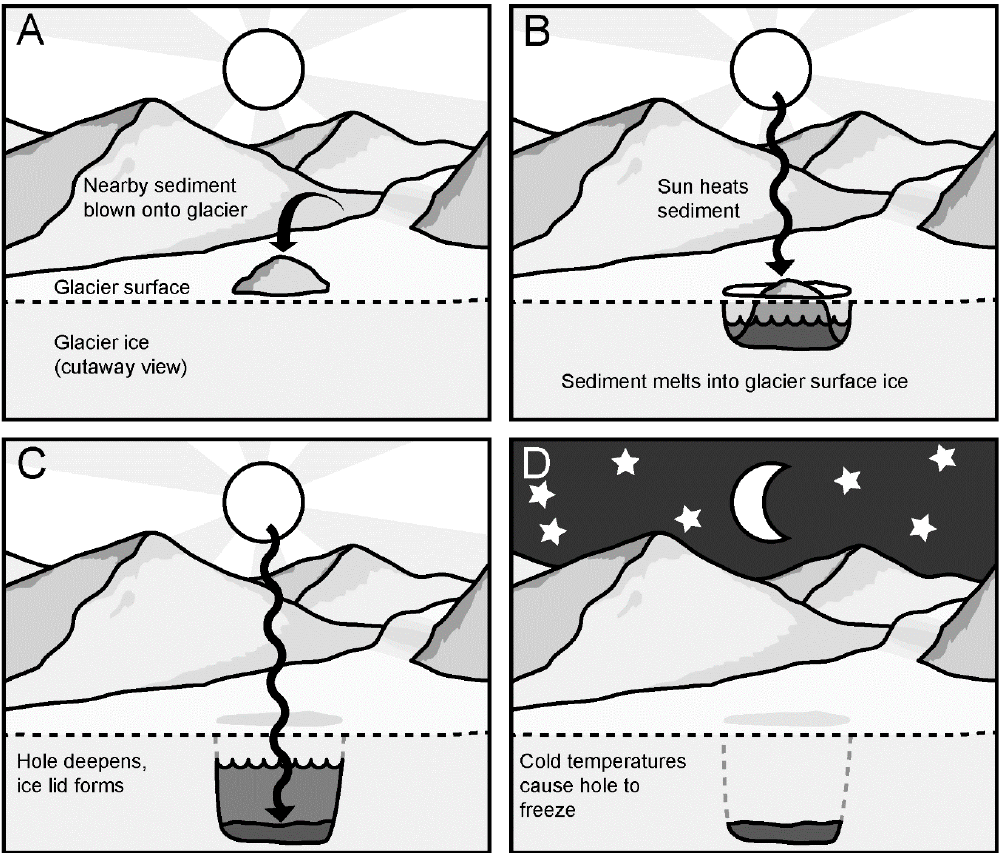
Figure 1. What is a cryoconite hole? ( A ): Cryoconite hole formation begins when sediment, often from nearby mountain slopes, is deposited onto a glacier’s surface. The sediment brings with it microbial life and nutrients, but it is dry and has low biomass. ( B ): The sediment has low albedo, meaning it absorbs solar radiation. This causes the sediment to warm, and melt into the glacier surface. This creates a relatively warm and wet environment; an oasis for microbial life. ( C ): Sediment melts deeper into the glacier until it is too deep to absorb enough radiation to continue melting. As temperatures get colder, an ice lid forms. ( D ): When solar radiation can no longer keep the hole warm and liquid, the water freezes and traps the sediment “puck” within the glacial ice. For Antarctic cryoconite holes, this freezing occurs at the end of the brief Antarctic summer, when there is no longer 24 h-sunlight to keep the hole warm.